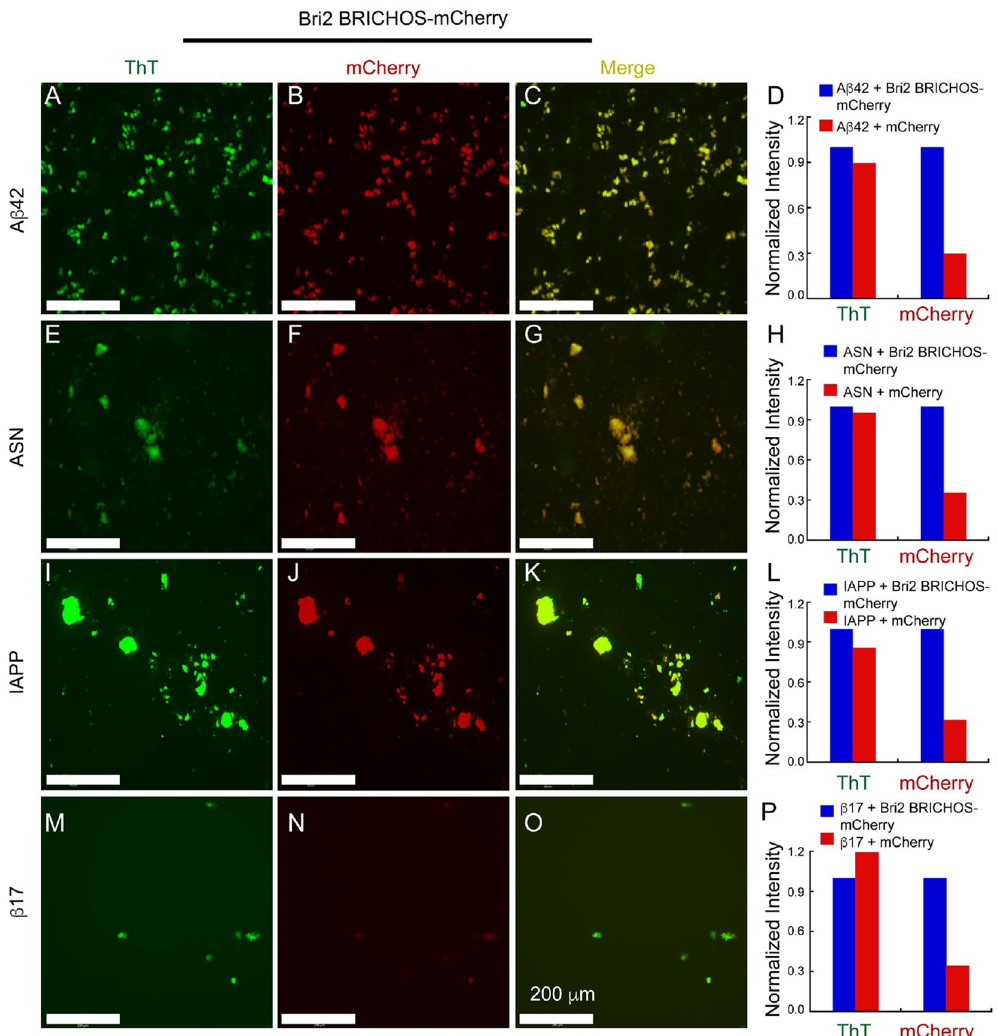
Figure 3. Rh Bri2 BRICHOS-mCherry binding to amyloid fibrils. ( A , E , I , M ) ThT staining of fibrillated Aβ 42 ( A ), α-synuclein (ASN) ( E ), IAPP ( I ) and β17 ( M ). ( B , F , J , N ) mCherry fluorescence of rh Bri2 BRICHOS- mCherry incubated with fibrillated Aβ 42 ( B ), ASN ( F ), IAPP ( J ) and β17 ( N ). ( C , G , K , O ), merged images of ThT and mCherry signals. ( D , H , L , P ) normalized signal intensities of ThT (left two histograms) and mCherry (right two histograms) for fibrils decorated with rh Bri2 BRICHOS-mCherry (blue histograms) or mCherry (red histograms). Images of Aβ 42 , ASN, IAPP and β17 fibrils incubated with mCherry are presented in Supplementary Figure